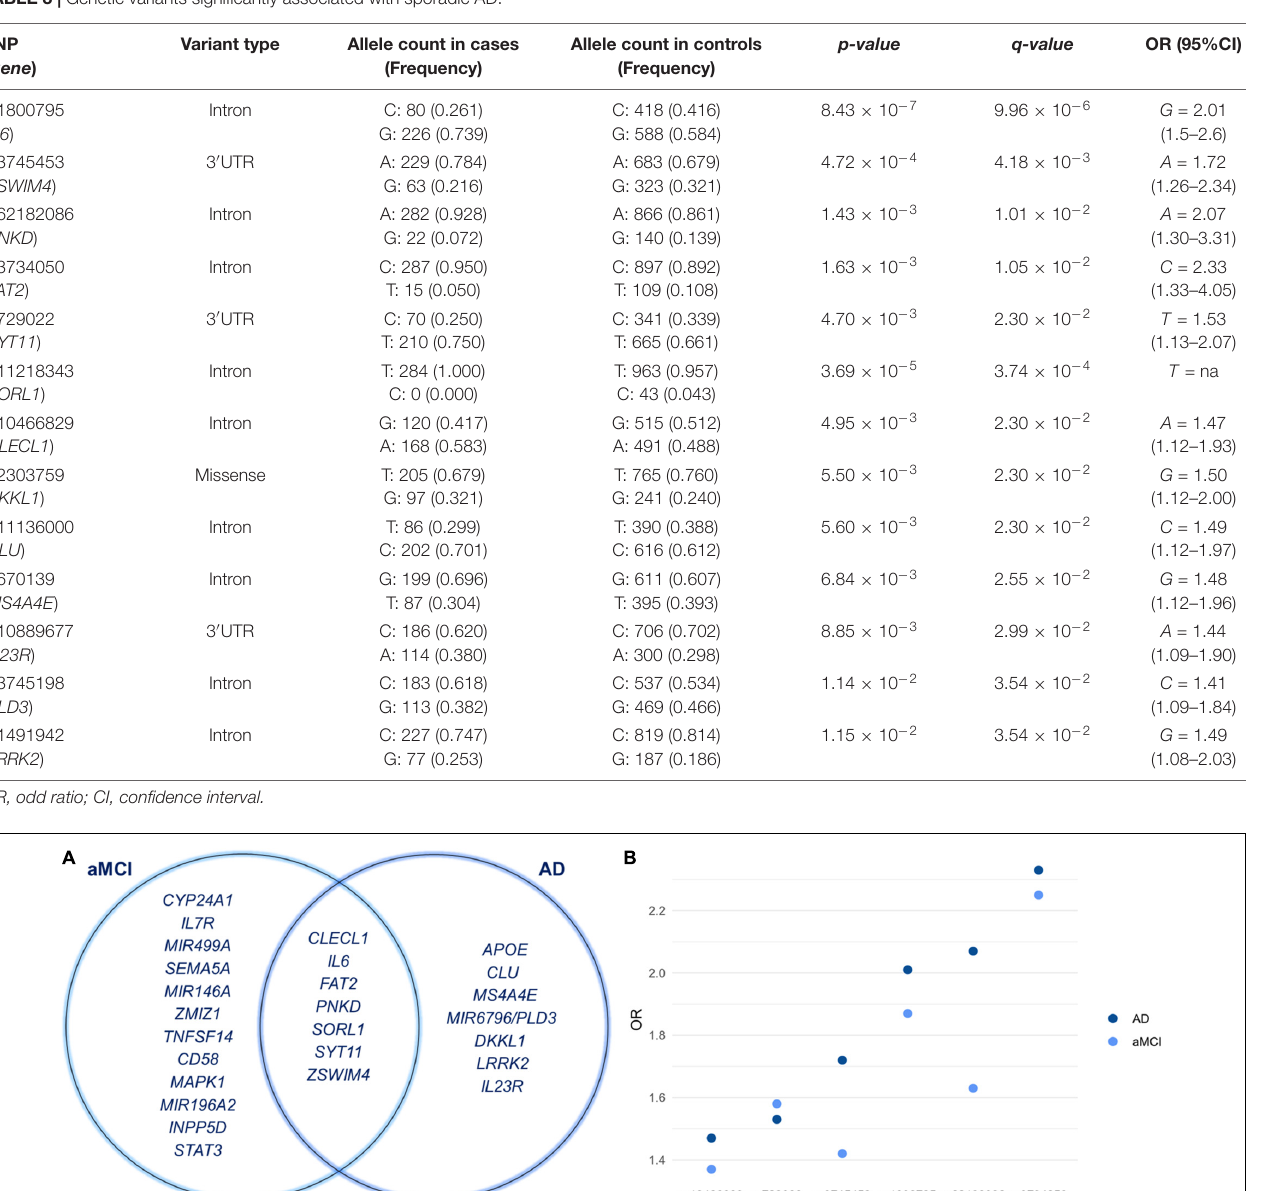
TABLE 3 | Genetic variants significantly associated with sporadic AD.